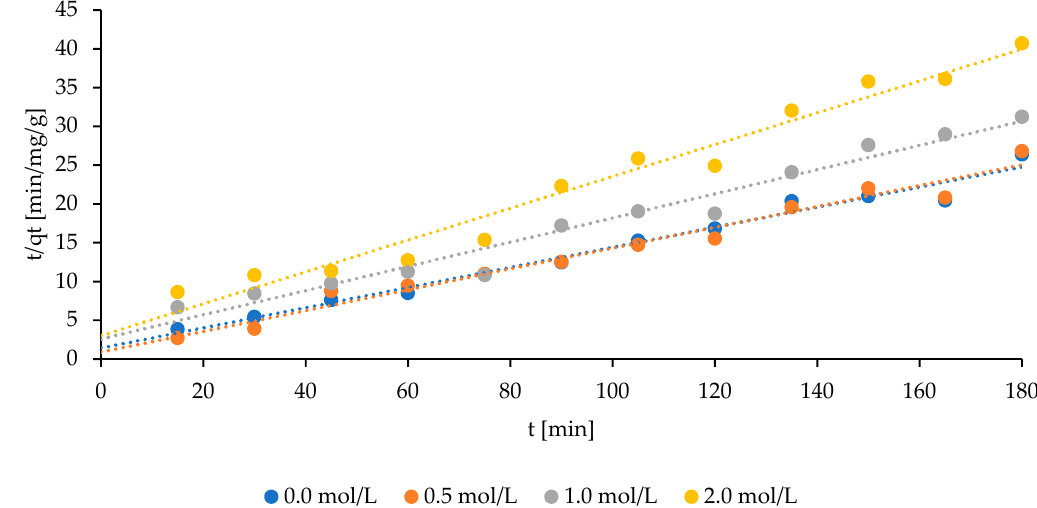
Figure 6. Adaptation of the experimental data of ammonium adsorption obtained for natural and modified Bentonite I—Langmuir isotherm.